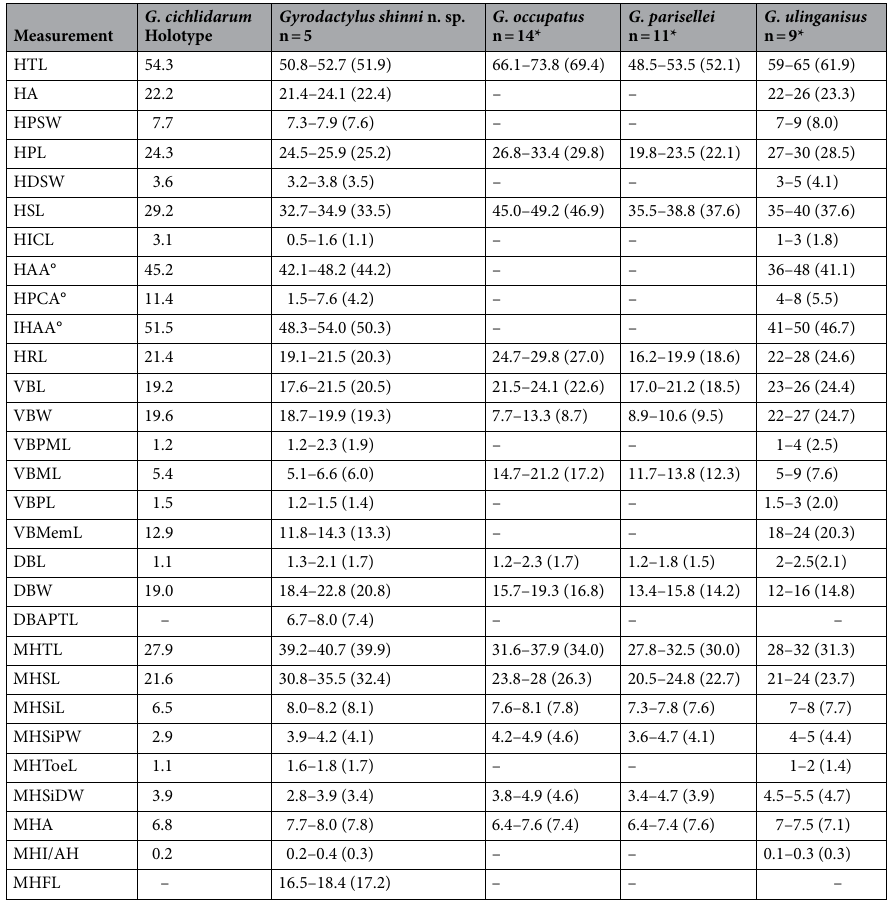
Table 2. Morphological measurements of Gyrodactylus shinni n. sp. from Oreochromis niloticus (L.) and an unidentified native cichlid collected from Chiapas. Data are presented alongside those of G. cichlidarum Paperna, 1968 from Sarotherodon galilaeus (L.) from Ghana, G. occupatus Zahradníčková, Barson, Luus-Powell & Přikrylová, 2016 from O. niloticus (L.) from Zimbabwe, G. parisellei Zahradníčková, Barson, Luus-Powell & Přikrylová, 2016 from Pseudocrenilabrus philander (Weber) which was collected from Zimbabwe, and G. ulinganisus García-Vásquez, Hansen, Christison, Bron & Shinn, 2011 from O. niloticus from South Africa. For each variable, the range, and the mean between parentheses are presented in micrometers. HTL hamulus total length; HA Hamulus aperture; HPSW hamulus point shaft width; HPL Hamulus point length; HDSW Hamulus distal shaft width; HSL Hamulus shaft length; HICL Hamulus inner curve length; HAA° Hamulus aperture angle; HPCA° Hamulus point curve angle; IHAA° Inner hamulus aperture angle; HRL Hamulus root length; VBL Ventral bar length; VBW Ventral bar width; VBPML Ventral bar process to mid length; VBML Ventral bar median length; VBPL Ventral bar process length; VBMemL Ventral bar membrane length, DBL Dorsal bar length; DBW Dorsal bar width; DBAPTL Dorsal bar attachment point length; MHTL Marginal hook total length; MHSL Marginal hook shaft length; MHSiL Marginal hook sickle length; MHSiPW Marginal hook sickle point width; MHToeL Marginal hook toe length; MHSiDW Marginal hook sickle distal width; MHA Marginal hook aperture; MHAA Marginal hook aperture angle; MHI/AH Marginal hook instep / arch height; MHFL marginal hook filament loop. *measurements taken from the original descriptions ( G. occupatus and G. parisellei Zahrandníčková et al., 2016; and G. ulinganisus García-Vásquez et al., 2011).